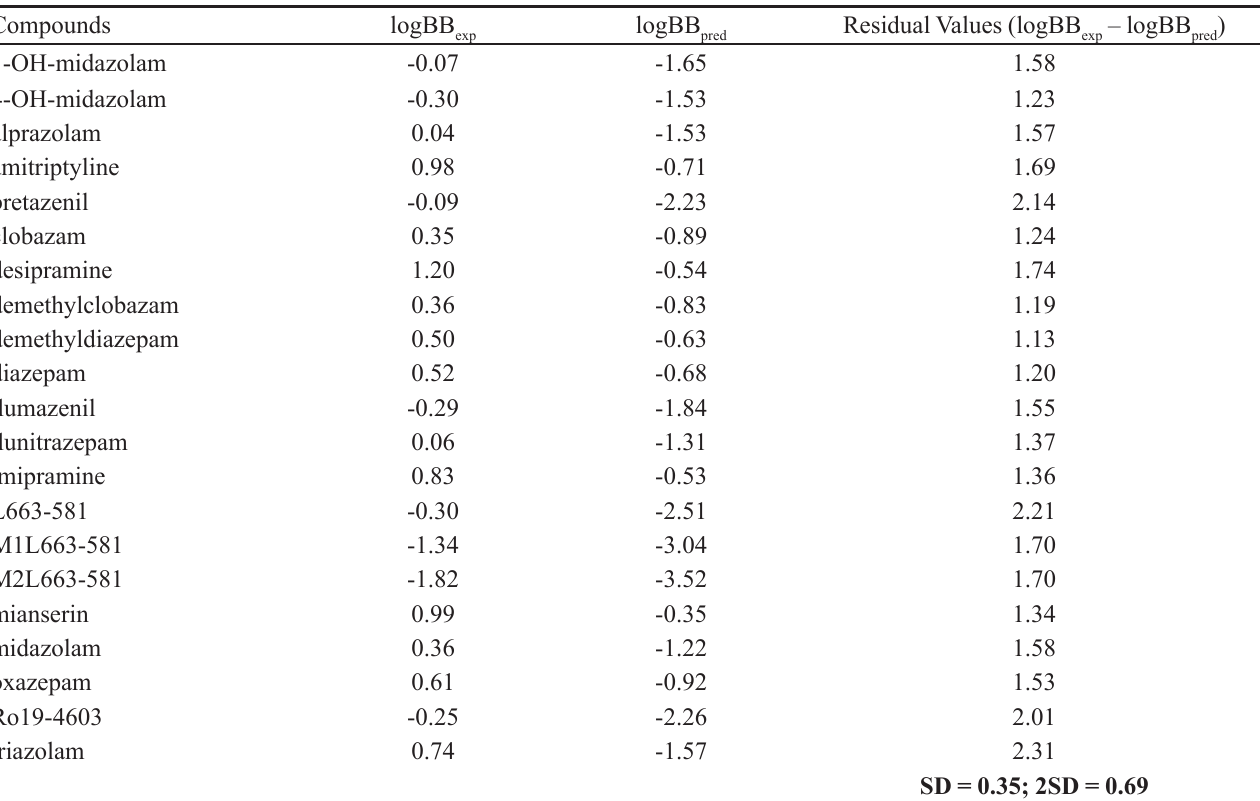
TABLE V - Residual values found for model 5